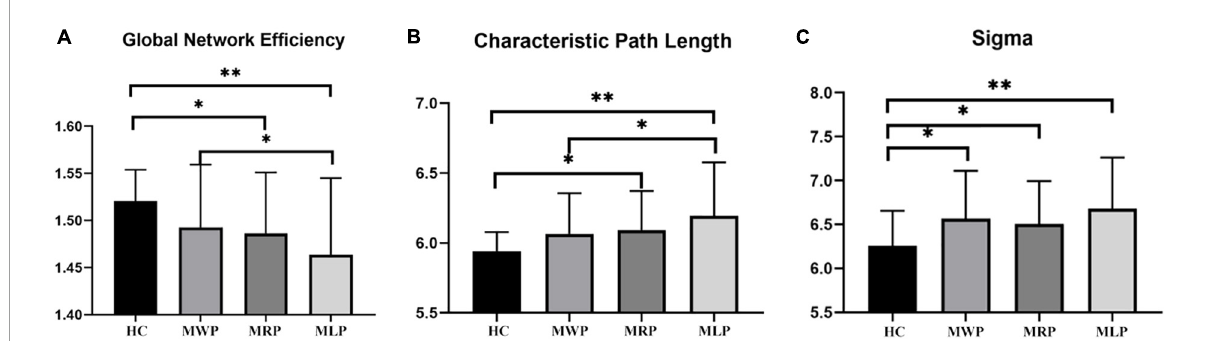
FIGURE4 Comparison of global network parameters. In comparison with the findings for healthy controls (HCs), global network efficiency (A) was decreased, and characteristic path length (B) was increased, both in the order of MMD patients without paresthesia (MWP), patients with right-limb paresthesia (MRP), and patients with left-limb paresthesia (MLP); in contrast, sigma values increased in the order of MRP, MWP, and MLP (C) . The asterisk (*) denotes results without family-wise error (FWE) correction, ** p < 0.05 after FWE correction, and *** p < 0.01 after FWE correction.